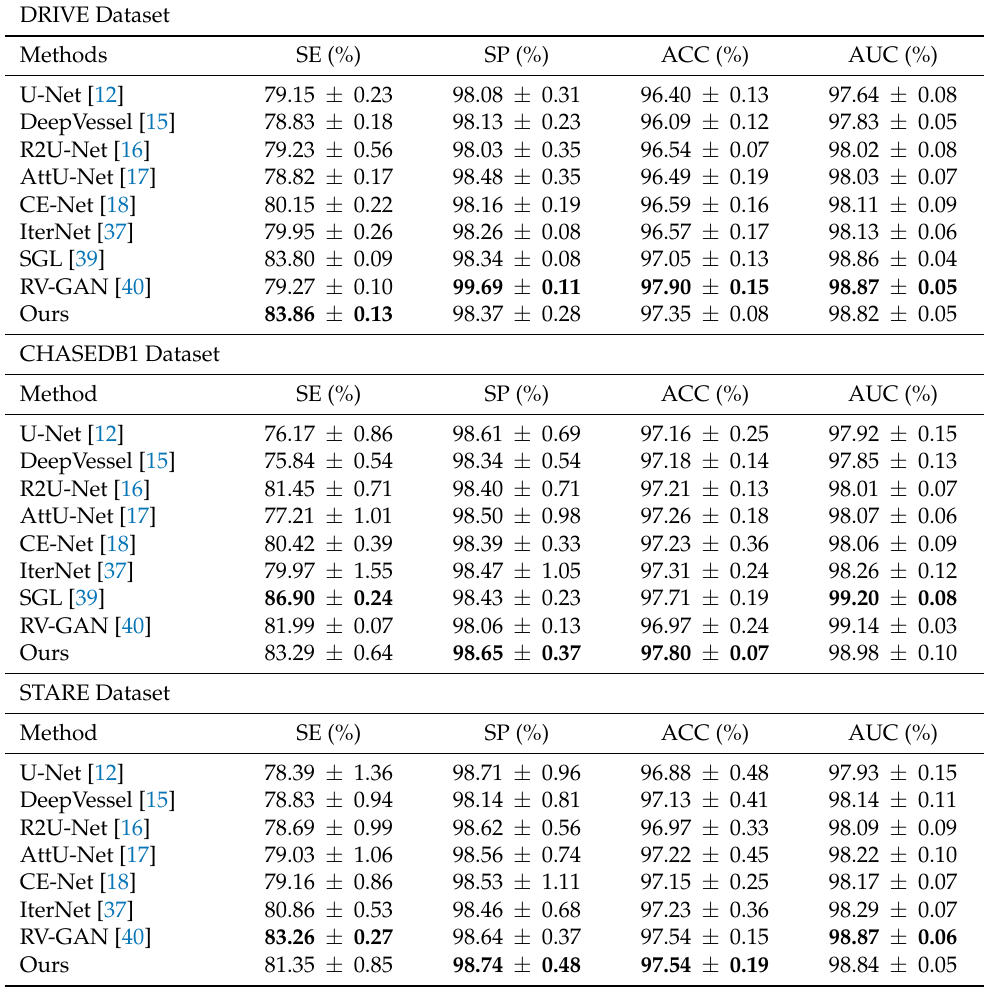
Table 1. Comparison with state-of-the-art methods on three classical datasets: DRIVE, CHASEDB1, and